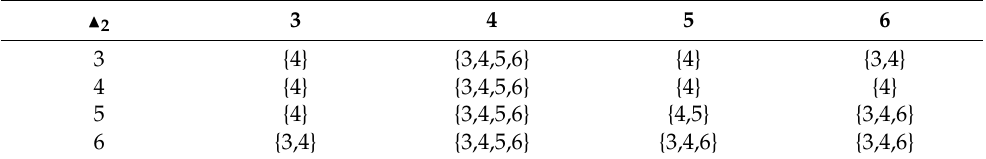
Table 8. The binary hypergroupoid ( C 2 , (cid:78) 2 ).